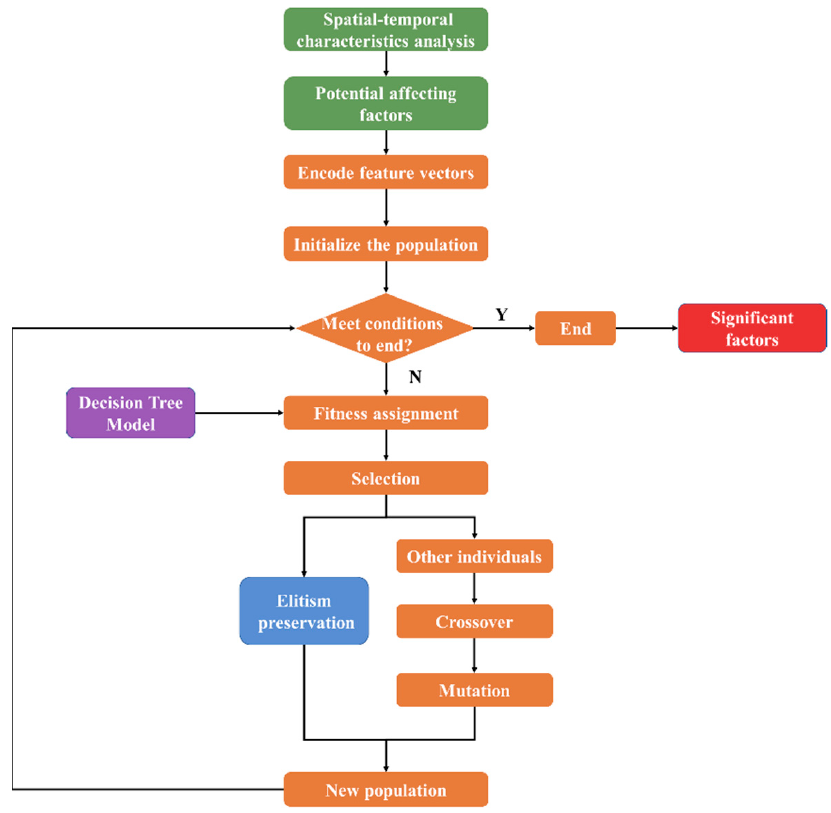
Figure 2. The overall framework of the eGA–DT model.